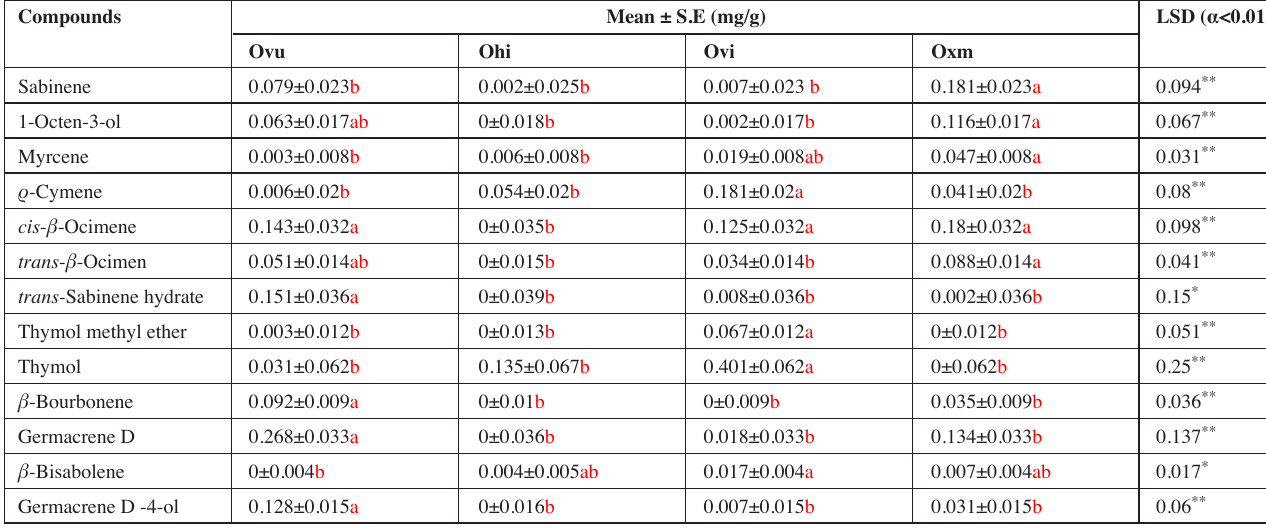
Tab. 4: Main chemical compounds in leaf samples of Origanum vulgare accessions detected by using GC/MS (S.E.: standard error of the mean; Ovu: ssp. vulgare , Ohi: ssp. hirtum , Ovi: ssp. viride , Oxm: ssp. viride × majorana )